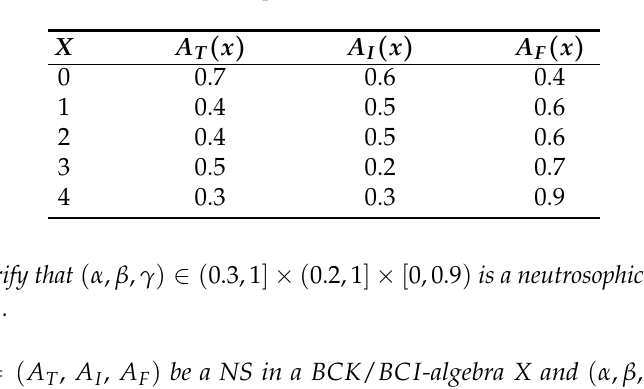
Table 6. Tabulation representation of A = ( A T , A I , A F )